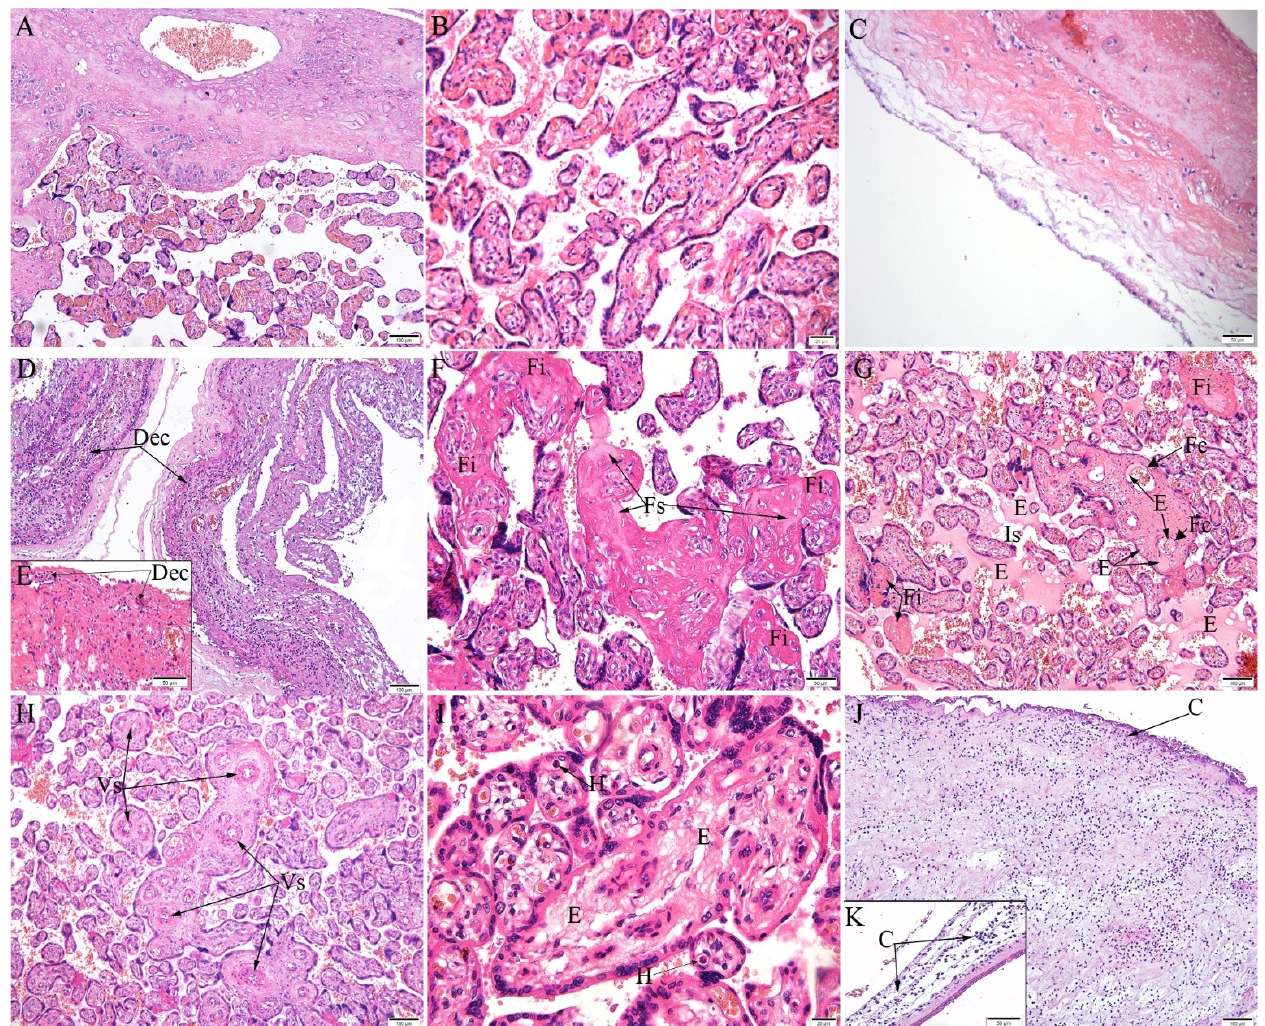
Figure 1. Histopathological changes in the placenta. ( A – C ) Control placenta (uninfected) with regular aspects: ( A ) decidua and chorionic villi, ( B ) chorionic villi, and ( C ) decidua. ( D – K ) CHIKV- infected placenta: ( D – E ) deciduitis (Dec); ( F ) fibrin deposition (Fi) and fibrosis (Fs); ( G ) edema (E) in intervillous space (Is), edema inside fetal capillaries (Fc), and fibrin deposition (Fi); ( H ) fetal vessel thickening (Vs); ( I ) edema (E) in chorionic villi, extramedullary hematopoiesis (H); ( J,K ) chorioamnionitis (C) in lower and higher magnification, respectively. Scale bar—( A , D , G , H , J ): 100 µm; ( B , I ): 20 µm; ( C , F , K ): 50 µm.